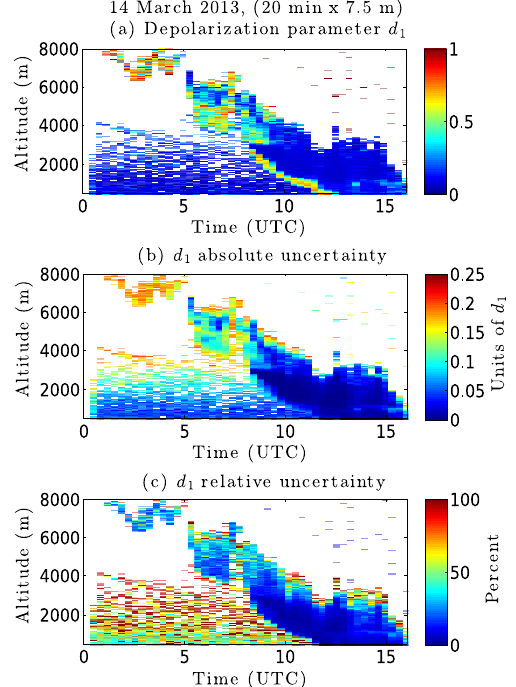
Figure 13. (a) The d 1 depolarization values from 14 March 2013, at 20min × 7.5m resolution. (b) The uncertainties associated with the d 1 values are all in units of depolarization parameter. (c) The relative uncertainties are in units of percent. Values indicated for the interior of the optically thick cloud are not valid, although they have been calculated.